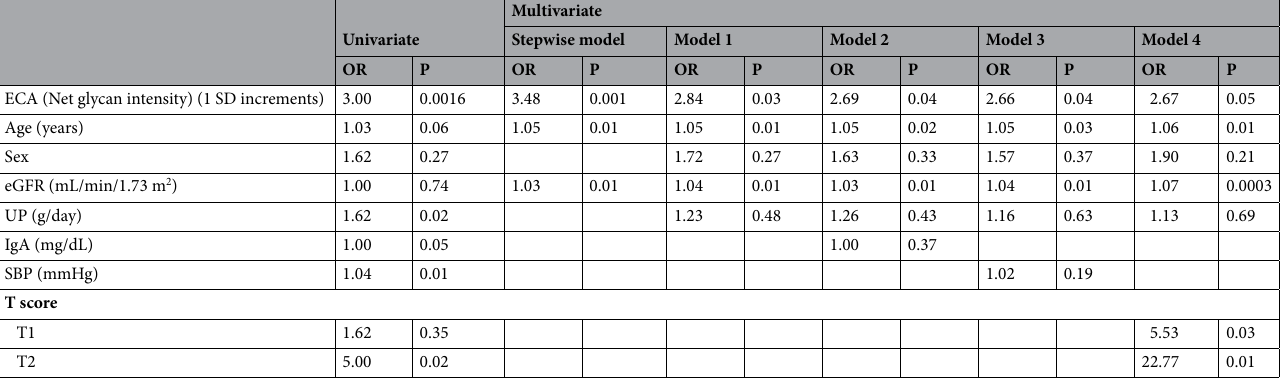
Table 2. Univariate and multivariate logistic regression models using ECA signal and established risk factors to predict renal outcome. Independent variables are as follow; Stepwise Model: ECA + Age + Sex + eGFR +